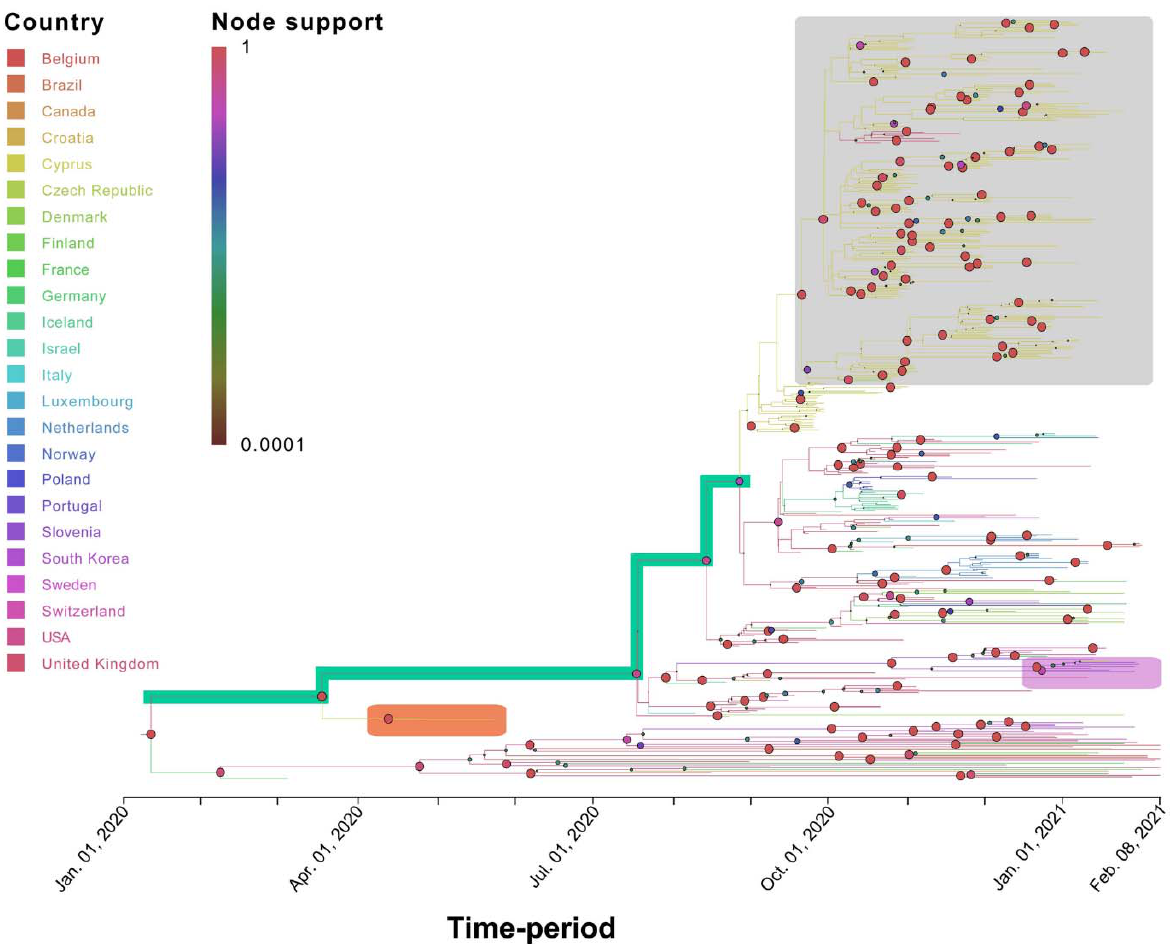
Figure 6. Time-scaled migration history for the B.1.258 dataset. The link between branch color and the inferred location (Country) is shown in the top left of the figure. The size and color of the circles at the nodes (representing inferred common ancestors) indicate their posterior support (node support); the level of node support (highest = 1 and lowest = 0.0001) corresponds to the size of the circle (higher support = larger circle size). The link between color and posterior node support is shown in the top left of the figure. The gray-shaded box indicates the well-supported B.1.258 Cyprus-specific lineage. The orange-shaded box indicates the two earliest Cypriot B.1.258 samples. The green-shaded branches indicate the backbone lineages. The pink-shaded box indicates the Cypriot sample that clustered among isolates from Slovenia and Switzerland. The x -axis represents the time-period of the reconstruction and was generated by the maximum clade credibility summary tree.